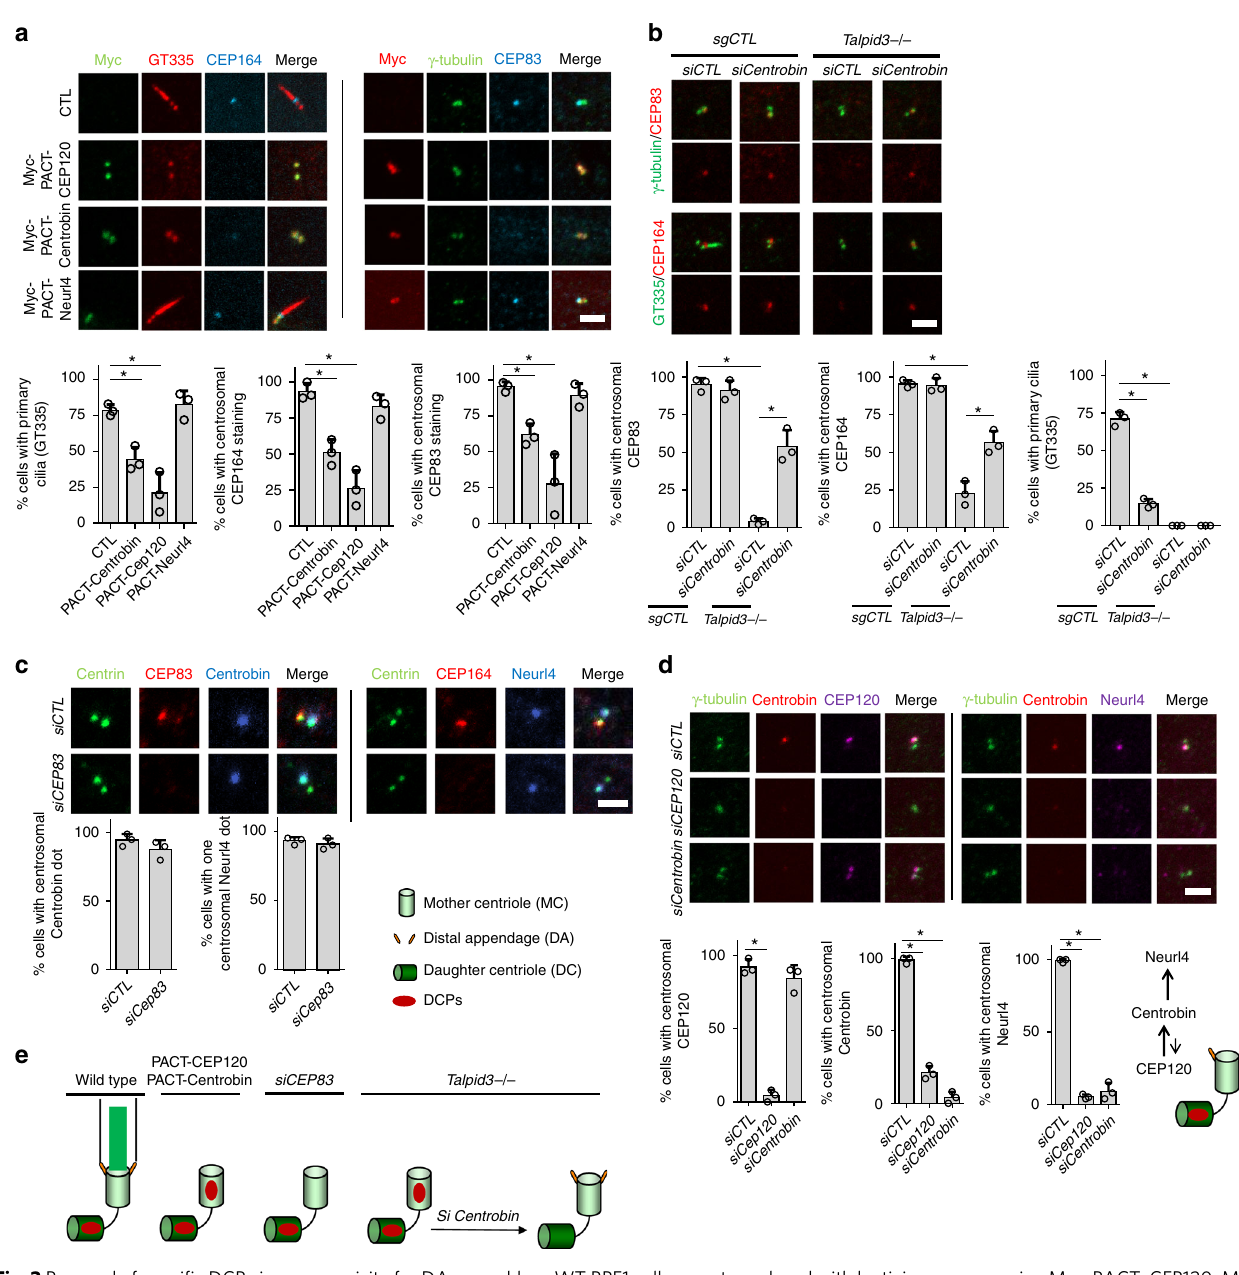
Fig. 3 Removal of speci fi c DCPs is a prerequisite for DA assembly. a WT RPE1 cells were transduced with lentiviruses expressing Myc-PACT – CEP120, Myc- PACT – Centrobin, or Myc-PACT-Neurl4, as indicated. Two days after transduction, cells were serum-starved for 48 h and examined by IF with antibodies against DA markers, CEP83 and CEP164. b Control and Talpid3 − / − cells were transfected with siRNAs against CEP120 (Supplementary Figures 2a, b) and Centrobin. Two days after transfection, cells were serum-starved for 24 h and examined by IF and WB using indicated antibodies. c WT RPE1 cells were transfected with siRNAs against CEP83. Two days after transfection, cells were serum-starved for 24 h and were visualized with indicated antibodies to check DA and DCPs. d WT RPE1 cells were transfected with siRNAs against CEP120 and Centrobin. Two days after transfection, cells were serum-starved for 24 h and then visualized with indicated antibodies to check the localization of DCPs, which are recruited as schematized (right). e Schematic of the relationship between removal of DCPs and DA assembly. Cumulative data from three independent experiments are shown. For each group, a minimum of 100 cells/experiment was averaged. All data are presented as mean ± SD. * p < 0.05 (unpaired t -test). Scale bars = 2 μ